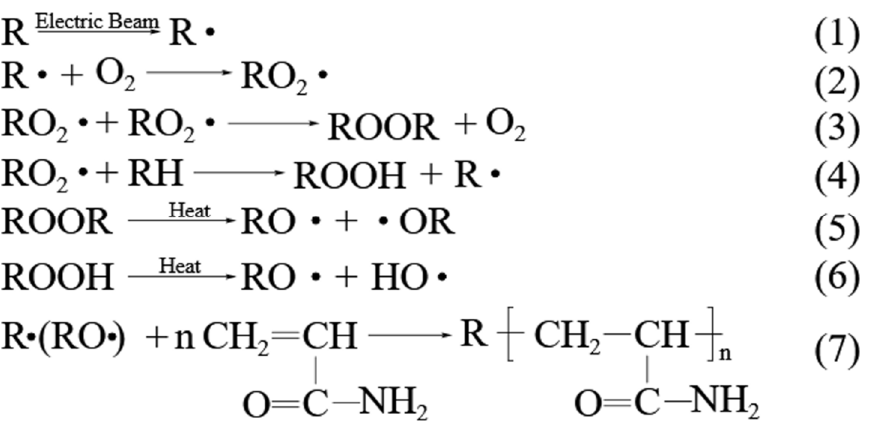
Figure 1. The reaction of the pre ‐ irradiation grafting.